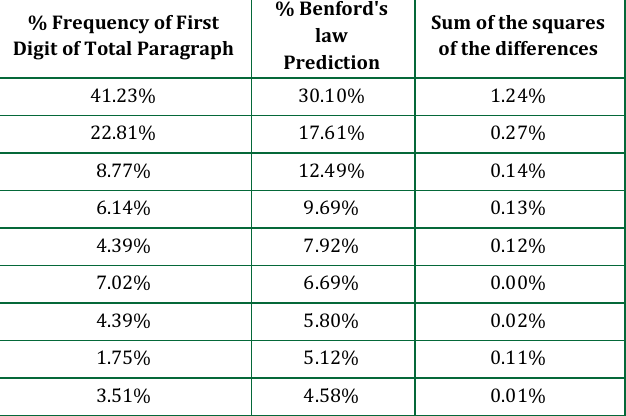
Table 4: Sum of the squares of the differences between frequency of total paragraph and the B enford’s law